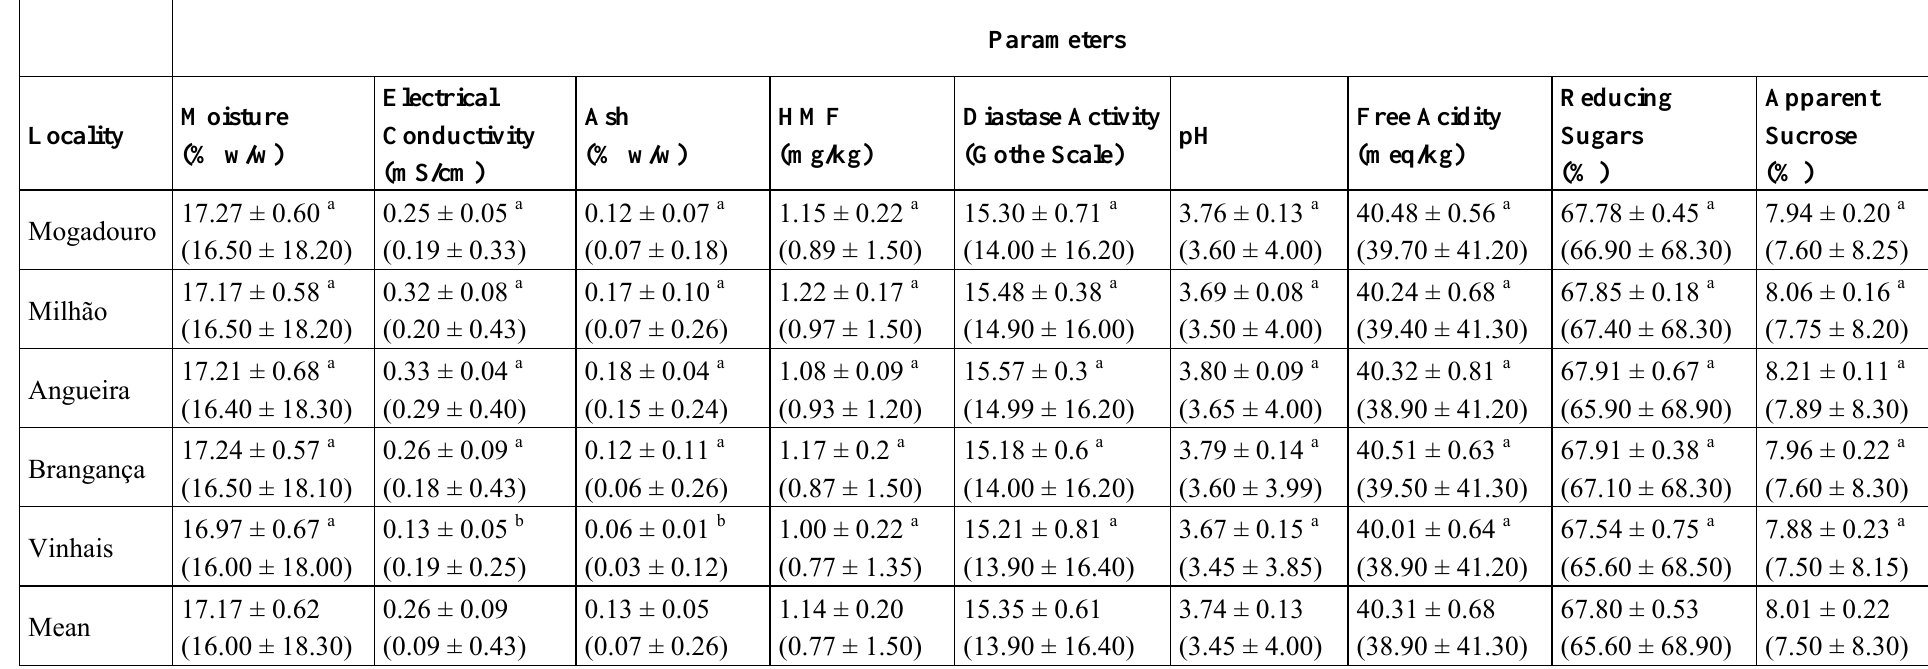
Table 2. Physicochemical parameters of analyzed organic honey